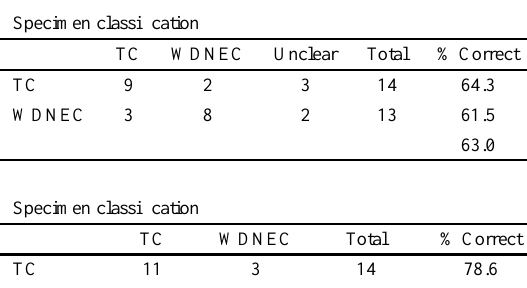
Specimen classification results of WDNEC and SCLC and selected features with F -values